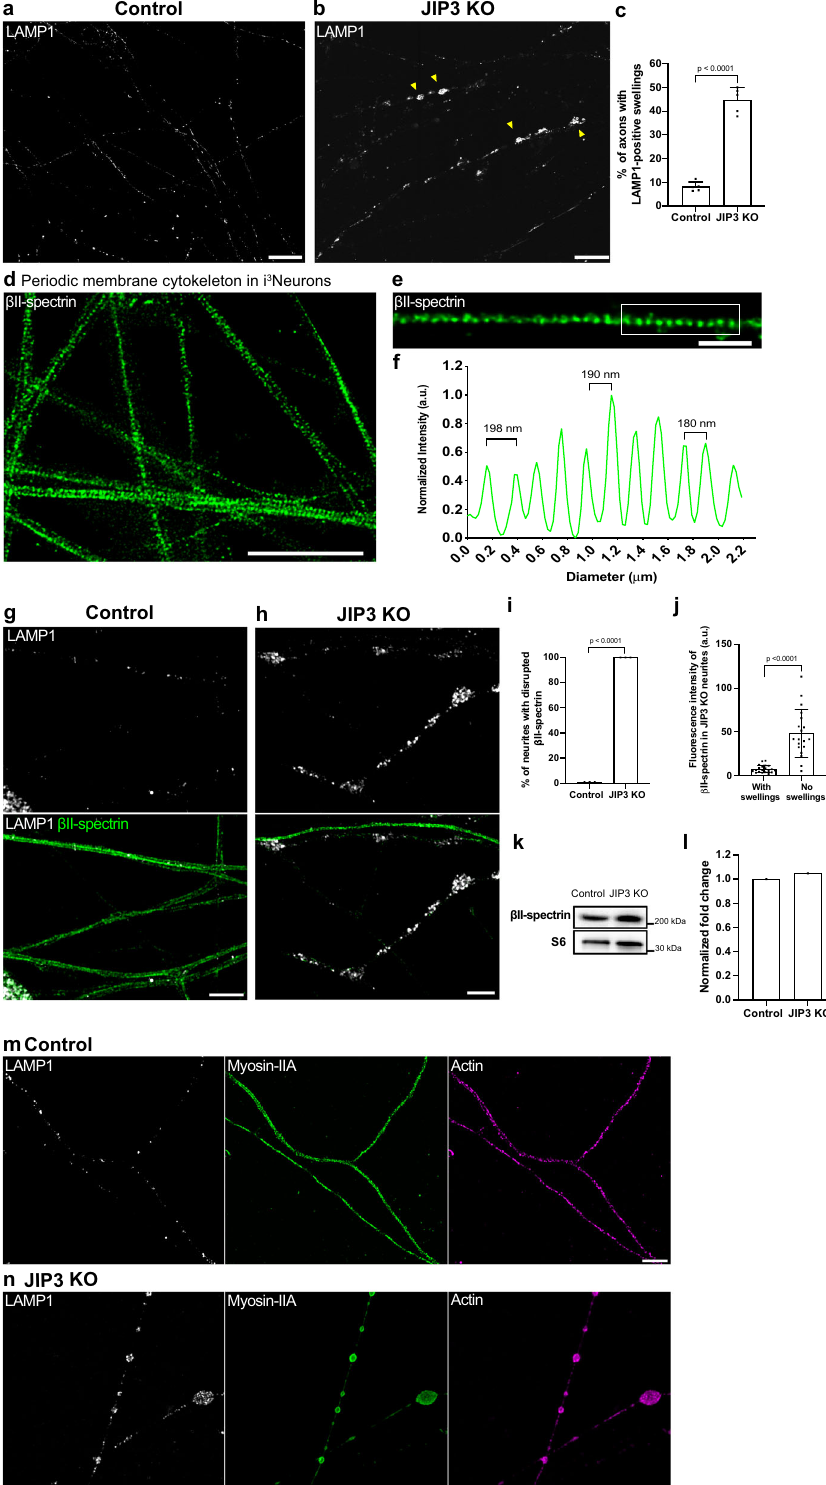
scaffold in the swollen axons of JIP3 KO i 3 Neurons (as well as the essential role for microtubules in long range axonal transport